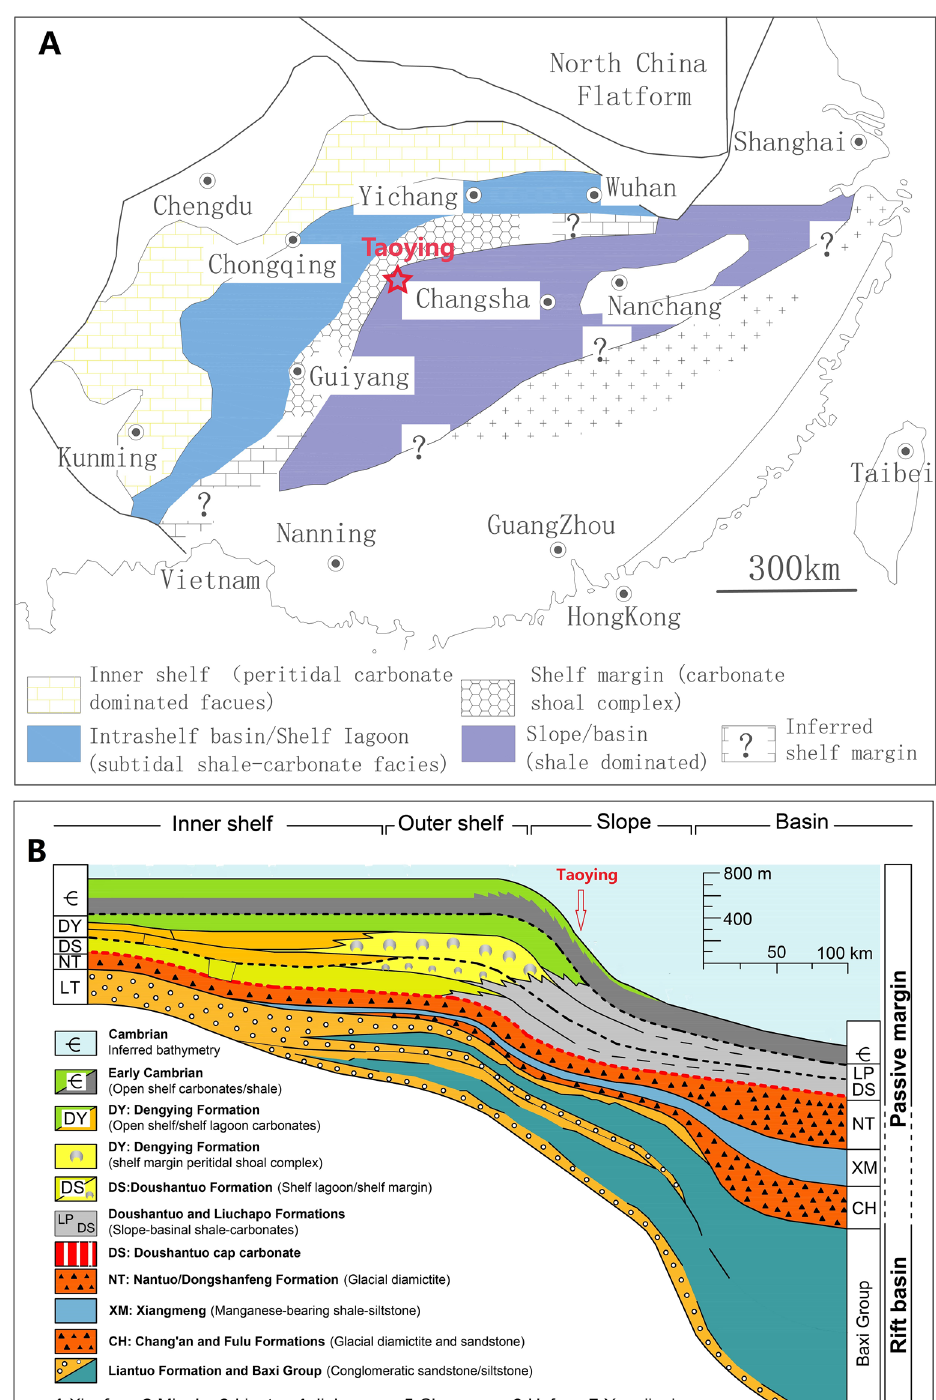
Figure 1. ( A ) a generalized paleogeographic reconstruction for the Yangze platform during Doushantuo deposition; ( B ) Shelf-to-basin transect from west to east in Guizhou and Hunan provinces 11 . The sample location is